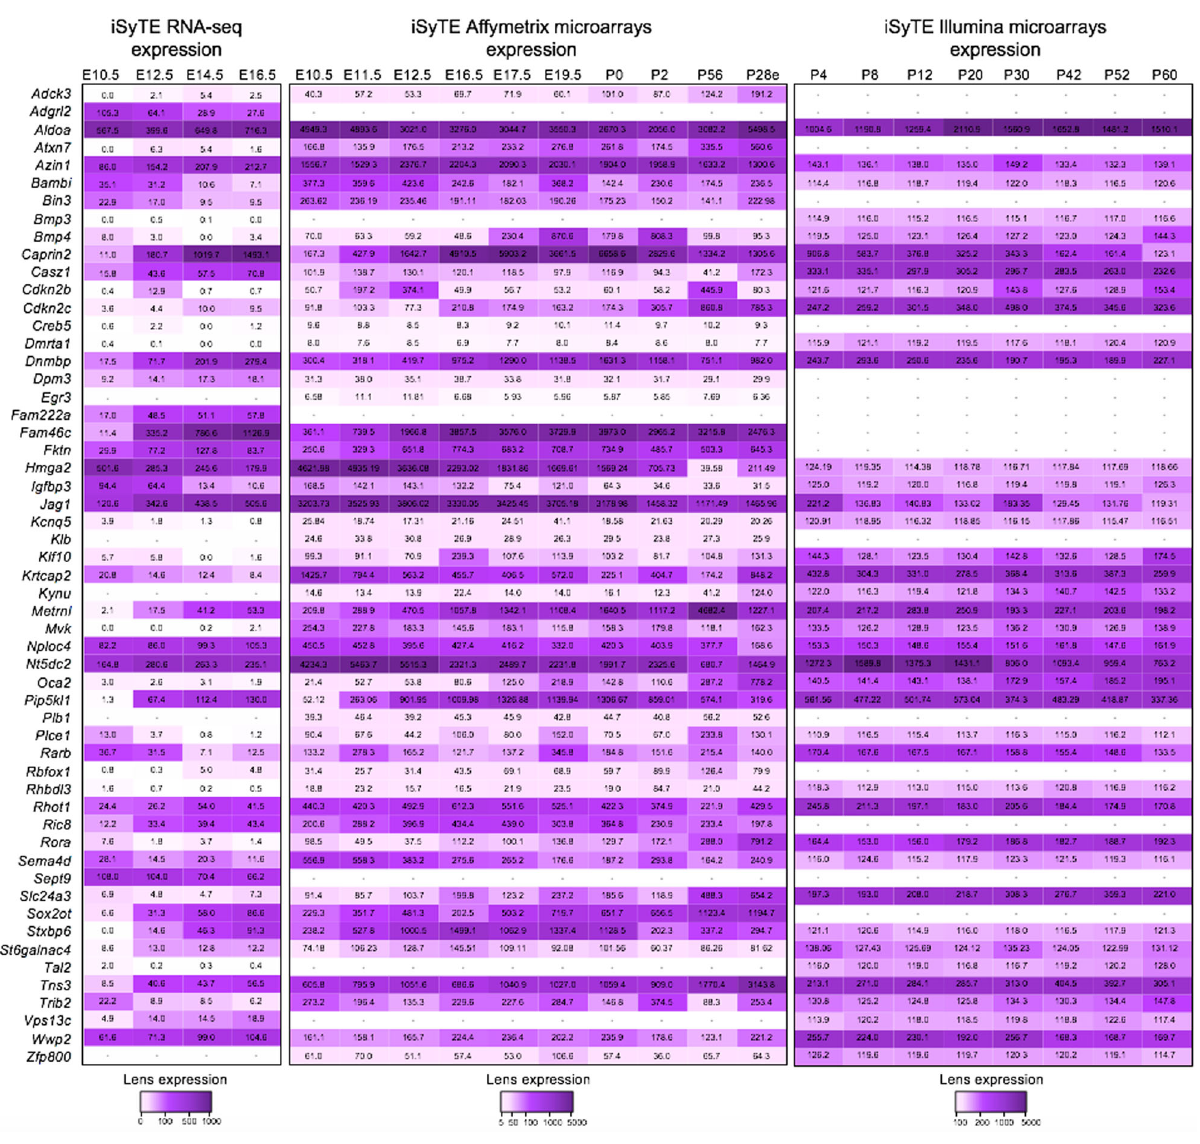
Fig. 3 Expression of candidate genes in mouse lens. Mouse orthologs of the human candidate genes in the 54 loci were examined for their lens expression in the iSyTE database. Analysis of whole lens tissue data on various platforms, microarrays (Affymetrix, Illumina) and RNA-seq indicates expression of 55 genes at different stages indicated by embryonic (E) and postnatal (P) days and ranged from early lens development (i.e., E10.5) through adulthood (i.e., P60). Note: P28 in Affymetrix represents expression data on isolated lens epithelium. The range of expression on each platform is indicated by a speci fi c heat-map. The numbers within individual tiles indicate the level of expression in fl uorescence intensity (for microarrays) and in counts per million (CPM) (for